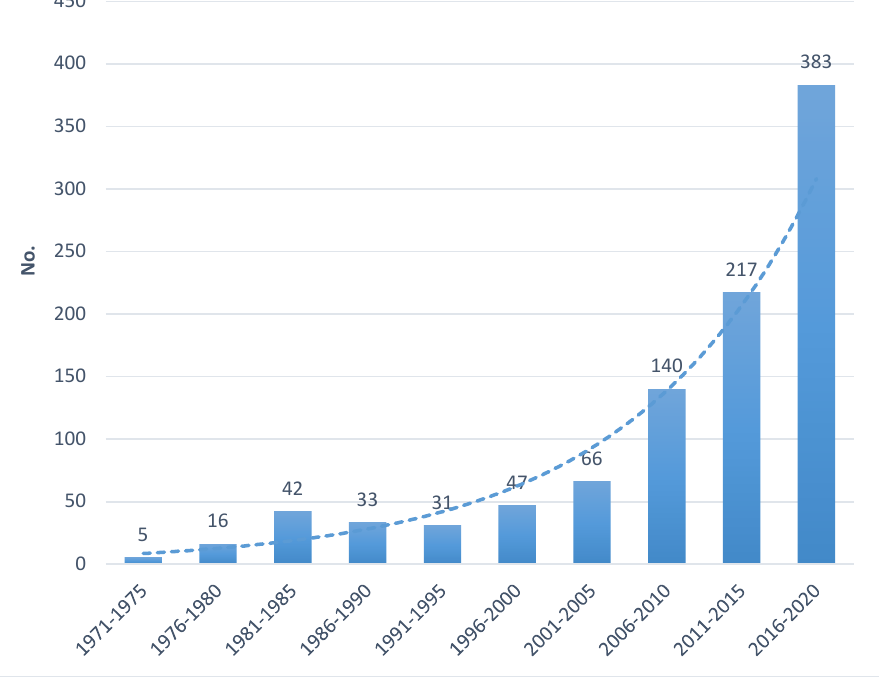
Fig. 3. The number of articles on political risk in WoS,